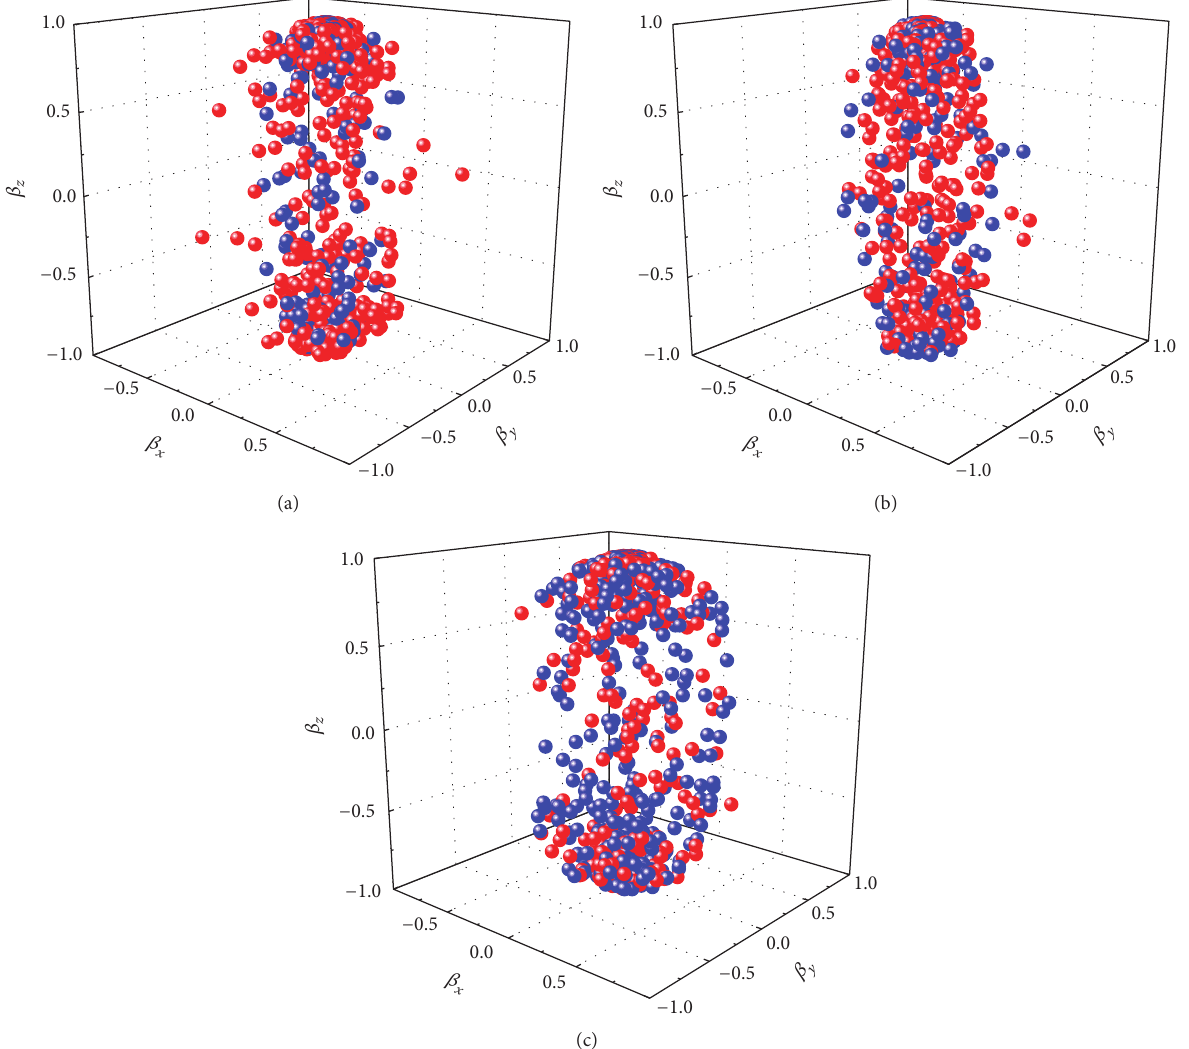
Figure 10: Same as Figure 4, but showing the results for (a) Υ(1𝑆) , (b) Υ(2𝑆) , and (c) Υ(3𝑆) mesons produced in pp collisions at √𝑠 = 7 TeV.